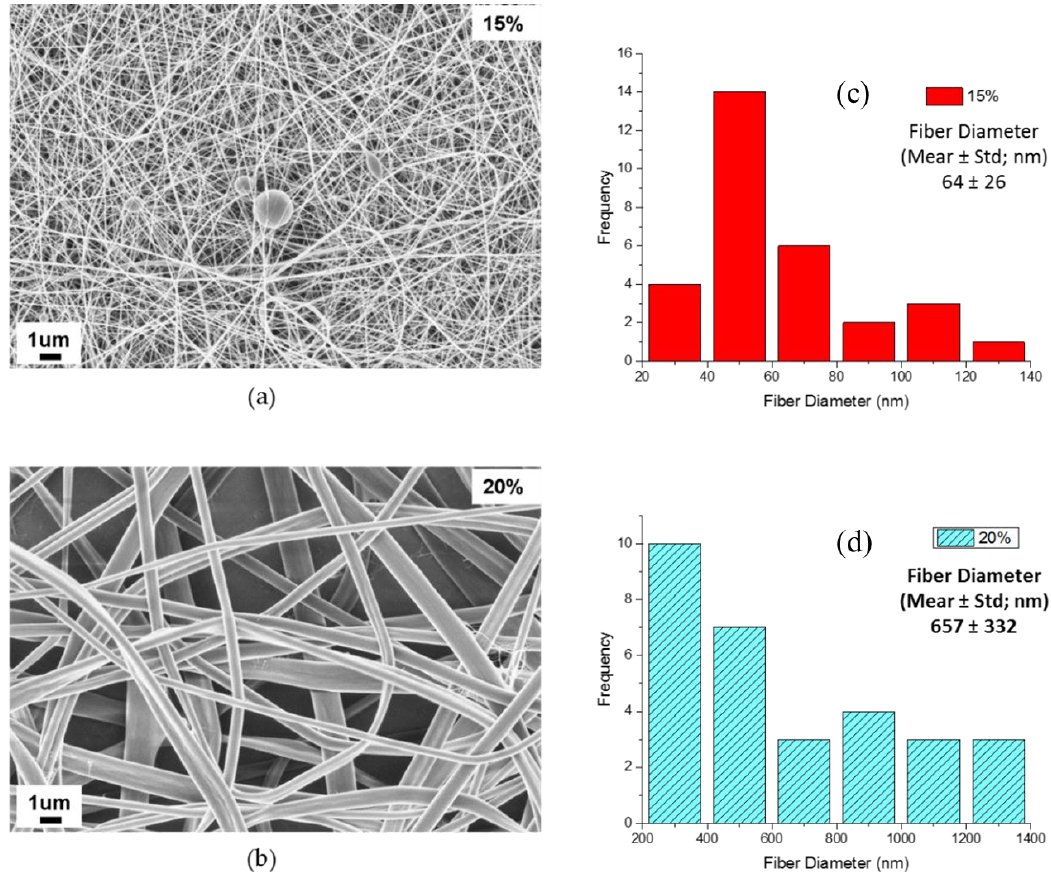
Figure 9. Field emission scanning electron microscope (FESEM) imaging of nylon 6 fibers electrospun from: ( a ) 15 wt % nylon 6 in 88% formic acid solutions; ( b ) 20 wt % nylon 6 in 88% formic acid solutions; ( c ) fiber diameter distribution from FESEM image ( a ) of nylon 6 electrospun from 15 wt % solutions; and ( d ) fiber diameter distribution from FESEM image ( b ) of nylon 6 electrospun from 20 wt % solutions. Table 5. Tensile properties of nylon 6 non-woven fiber mats electrospun from 20 wt %, 20 wt %, and 15 wt %